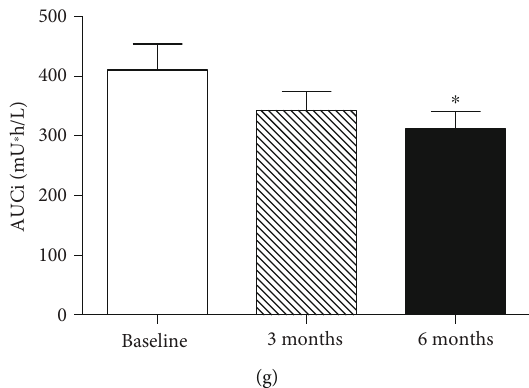
Figure 3: E ff ects of GLP-1RA treatment on circulating Fetuin-B and insulin sensitivity in PCOS women. (a) M values in PCOS subjects during the EHC after GLP-1RA treatment. (b) Average GIR in PCOS subjects during the EHC at pre- and posttreatment. (c) Serum Fetuin-B levels in PCOS subjects before and after GLP-1RA treatment. (d) Blood glucose 572 levels in PCOS subjects during an OGTT at pre- and posttreatment. (e) AUCg in PCOS subjects during an OGTT at pre- and posttreatment. (f) Insulin levels in PCOS subjects during an OGTT at pre- and posttreatment. (g) AUCi in PCOS subjects during an OGTT at pre- and posttreatment. Data are means ± SEM . ∗ p < 0 : 05 or ∗∗ p < 0 : 01 vs.